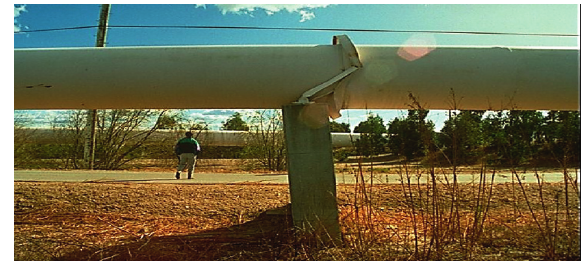
Figure 10: Demolition of pipes’ support due to soil liquefaction in the Northbridge earthquake (1994).